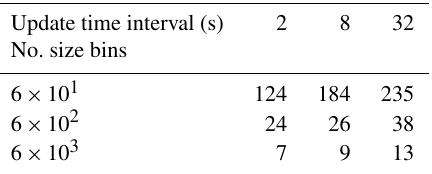
Table 5. Processing times (seconds) for a 6h experiment with α - pinene ozonolysis including nucleation. Size bin numbers are in columns, and temporal resolutions are in